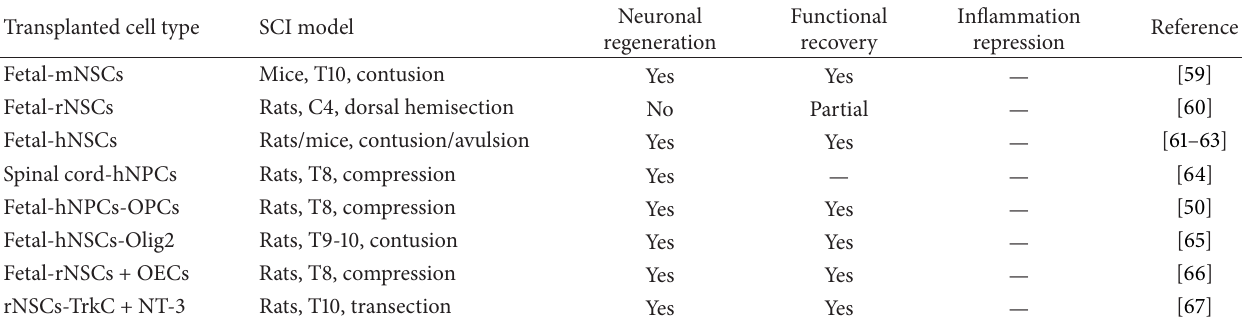
Table 3: Preclinical spinal cord injury trials using neural stem cells (NSCs)/neural progenitor cells (NPCs). Transplanted cell type